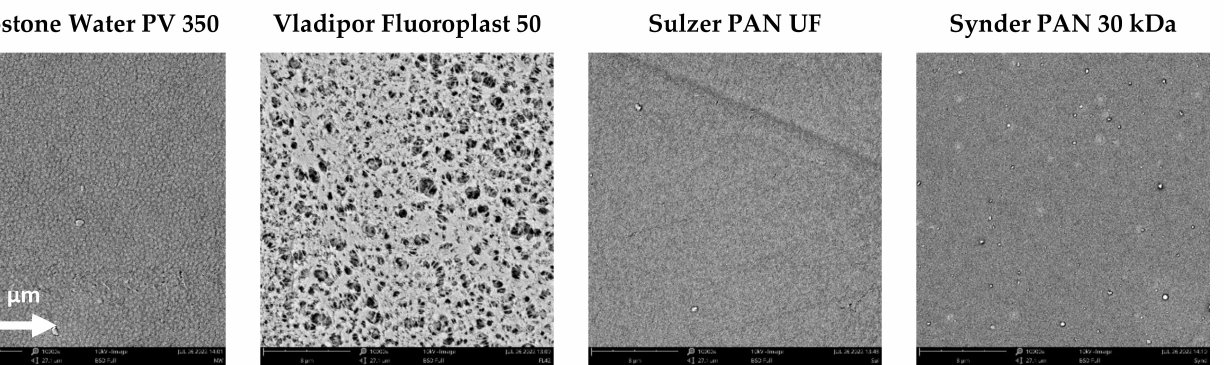
Figure 3. SEM images of the upper surface for the porous membranes used as supports for the TFC. preparation. The imagines were acquired after Au metallization with a magnification of 10,000 × and a primary beam voltage of 10 KV. The scale bar is identical for all samples.